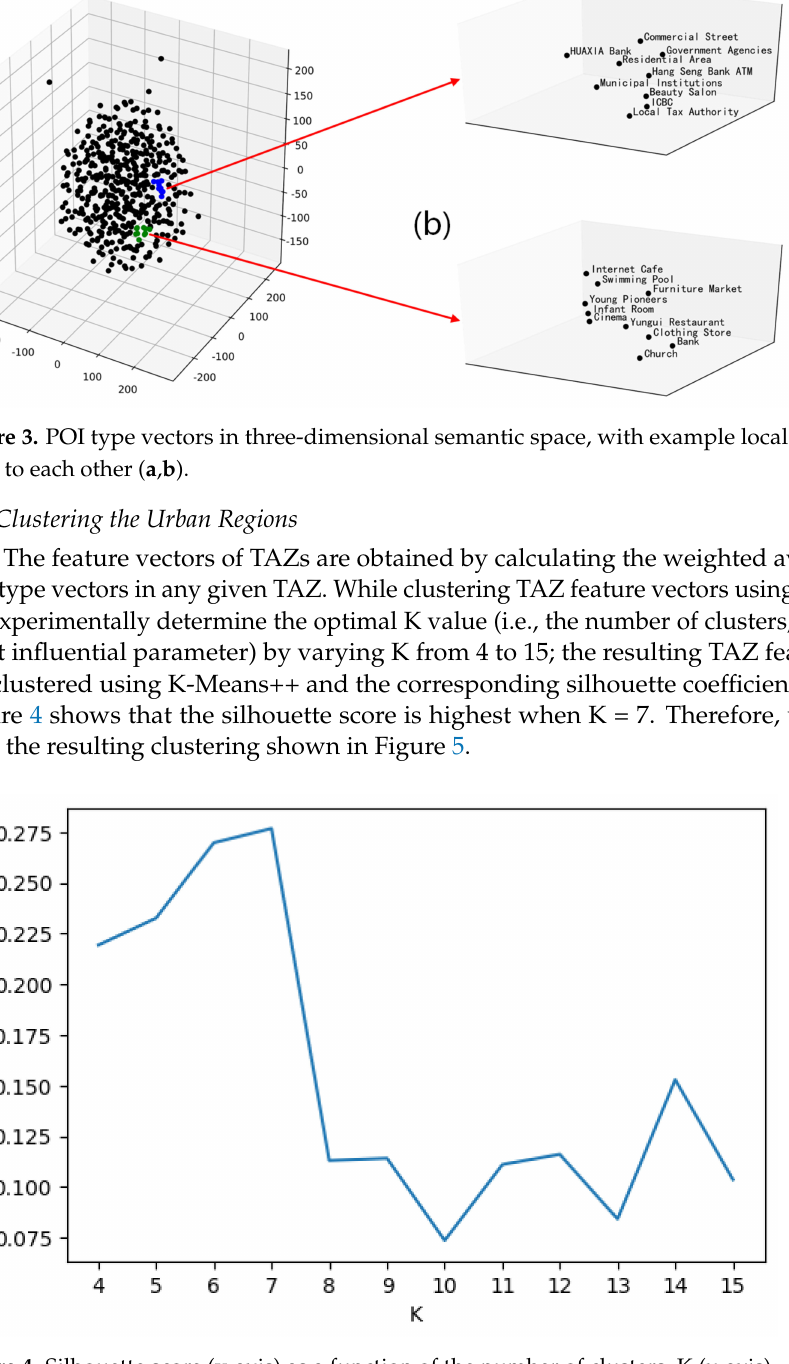
Figure 4. Silhouette score (y-axis) as a function of the number of clusters, K